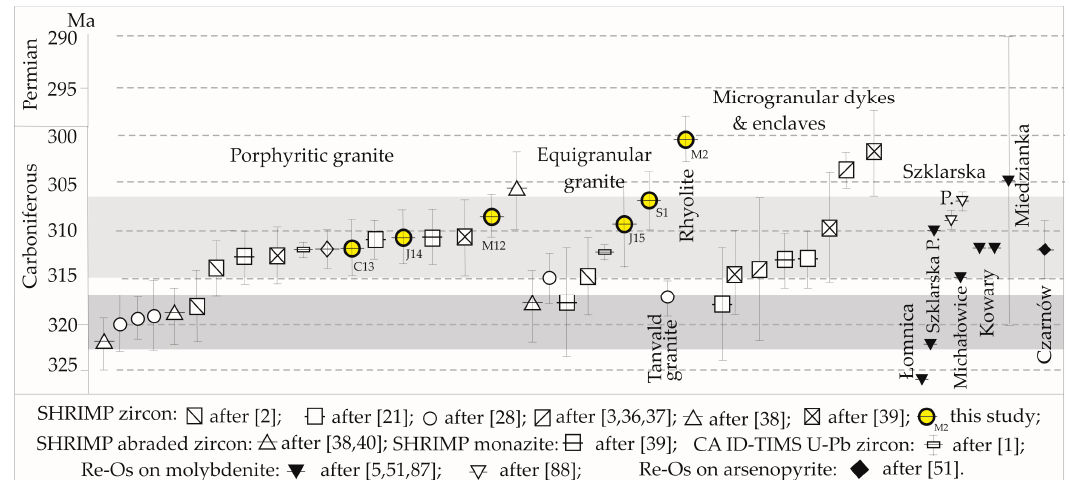
Figure 12. U-Pb and Re-Os isotopic geochronology of igneous rocks and sulfides from the KP and its eastern metamorphic cover.